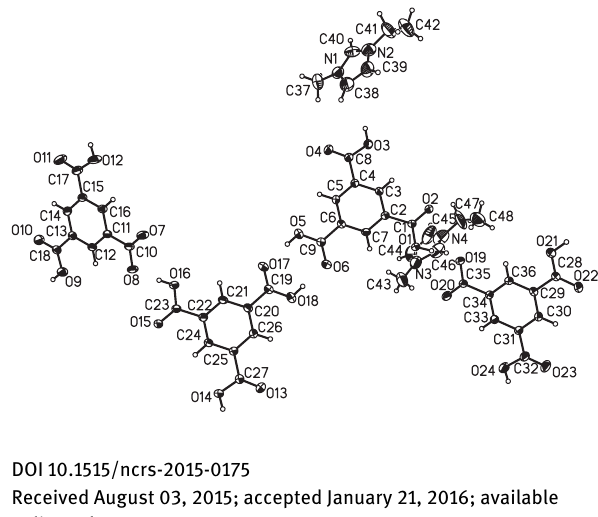
Table 1: Data collection and handling.